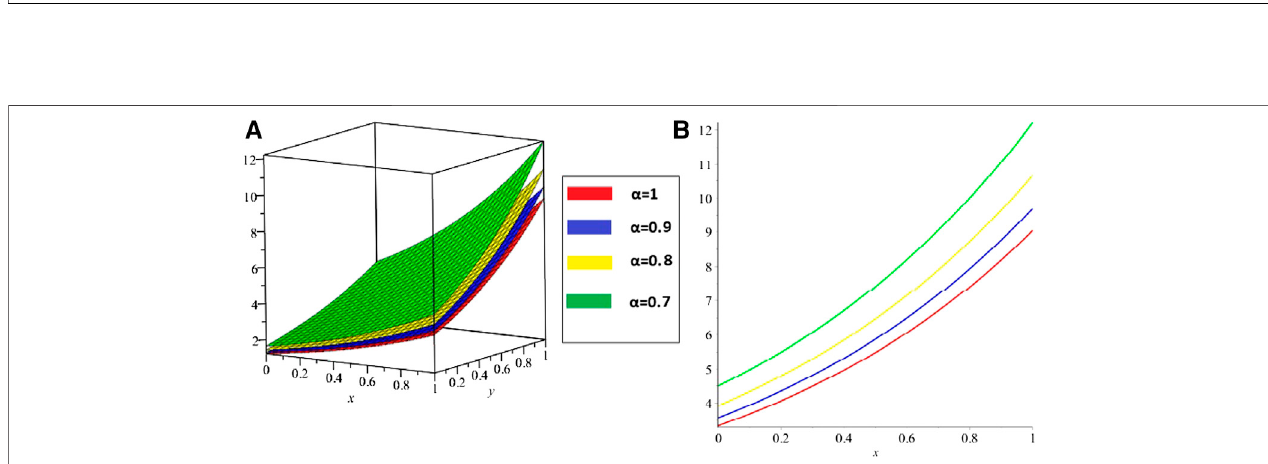
FIGURE4| ISTMsolutionofexample2 (C) at various fractional-order α (D) thefractional-order solutionsat ξ (cid:2) 0 . 5.In Figure4 ,the ISTMsolutionsofExample2at different values of α are presented. The sub-graphs (C) and (D) represents 3D and 2D plots of fractional order solutions of Example 2. The convergence of the fractional solutions towards integer solutions is